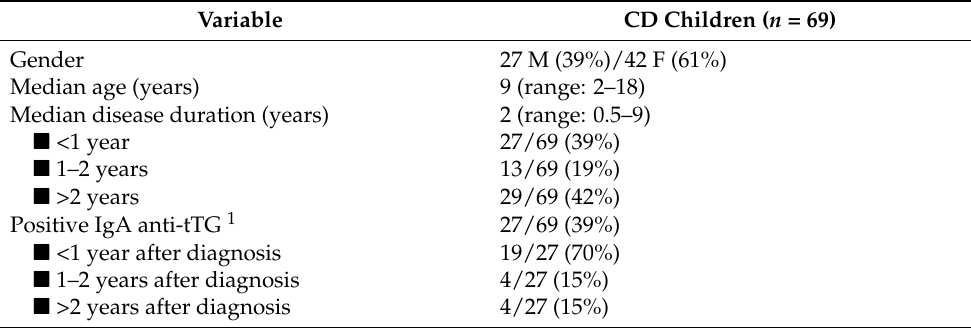
Table 1. Demographic and clinical data of the study-group.